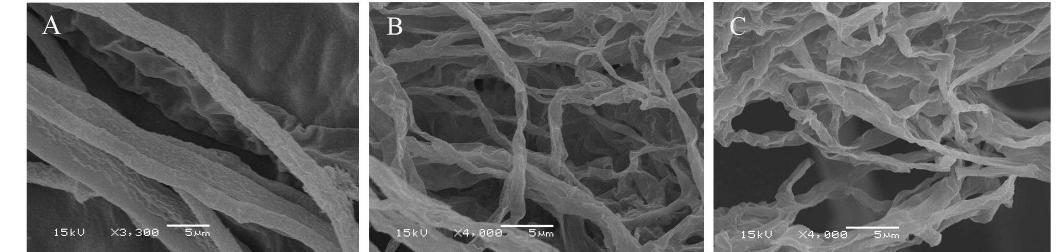
Figure 3. Effect of propolis on the hyphal morphology of P. notatum. ( A ) Control, ( B ) ethanol extracts of propolis from United States (EEP-A), ( C ) ethanol extracts of propolis from China (EEP-C).